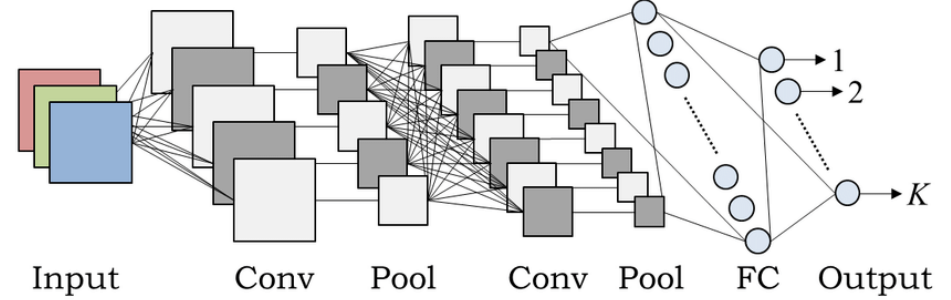
Figure 4. An example of CNN architecture. The way in which the layers are structured, which elements are used in each layer and how they are designed will often affect the speed and accuracy with which it can perform various